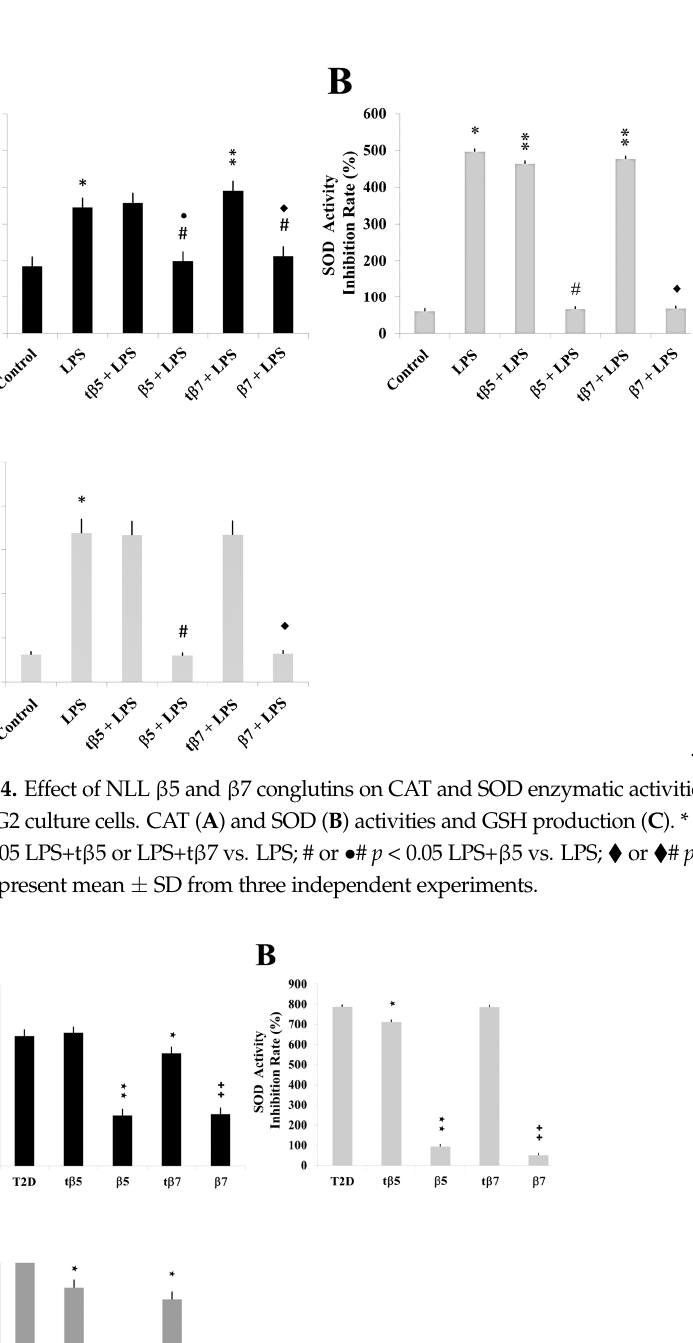
Figure 6. E ff ect of NLL β 5 and β 7 conglutins on CAT and SOD activities and GSH production in healthy subject culture cells. CAT ( A ) and SOD ( B ) activities and GSH production ( C ). * p ˂ 0.05 LPS vs. control; # p ˂ 0.05 LPS+ β 5 vs. LPS; ◆ p ˂ 0.05 LPS+ β 7 vs. LPS. Data represent mean ± SD from three independent experiments.